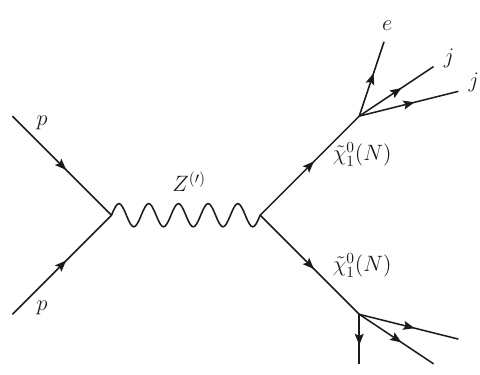
Figure 4 . Feynman diagram of the signatures. We require at least one neutralino or HNL to decay into the ejj final state, as well as one hard prompt ISR jet in the event